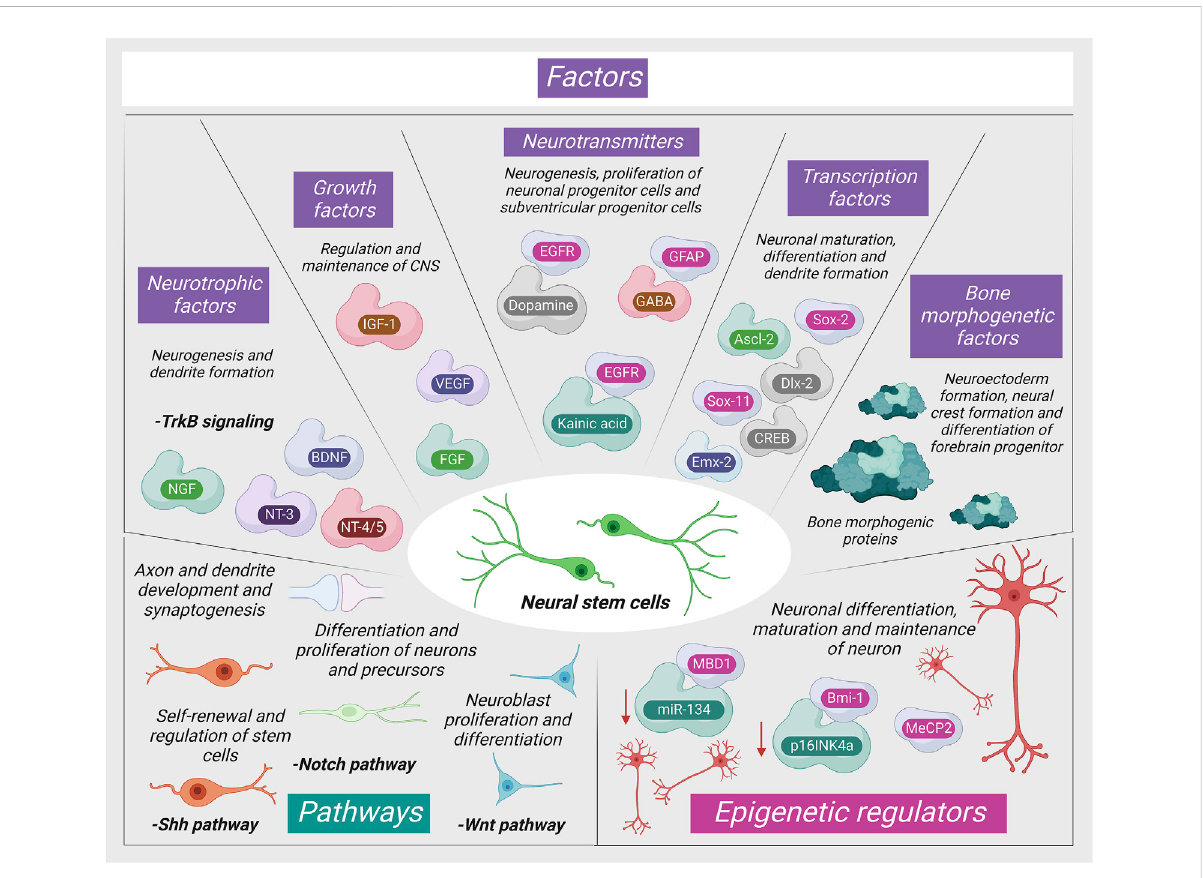
FIGURE 1 Mechanism of neurogenic signaling of stromal cells (MBD1: Methyl-CpG-binding domain protein one; NGF: Nerve Growth Factor; NT-3: Neurotrophinthree; MeCP2: Methyl-CpG-bindingproteintwo;BDNF: Brain-derived neurotrophic factor; IGF-1: Insulin-like growth factor; NT-4/5: Neurotrophin 4/5; VEGF: Vascular endothelial growth factor; MeCP2: Methyl-CpG-binding protein two; FGF: Fibroblast growth factor; Mll1: Mixed- lineage leukemia 1).